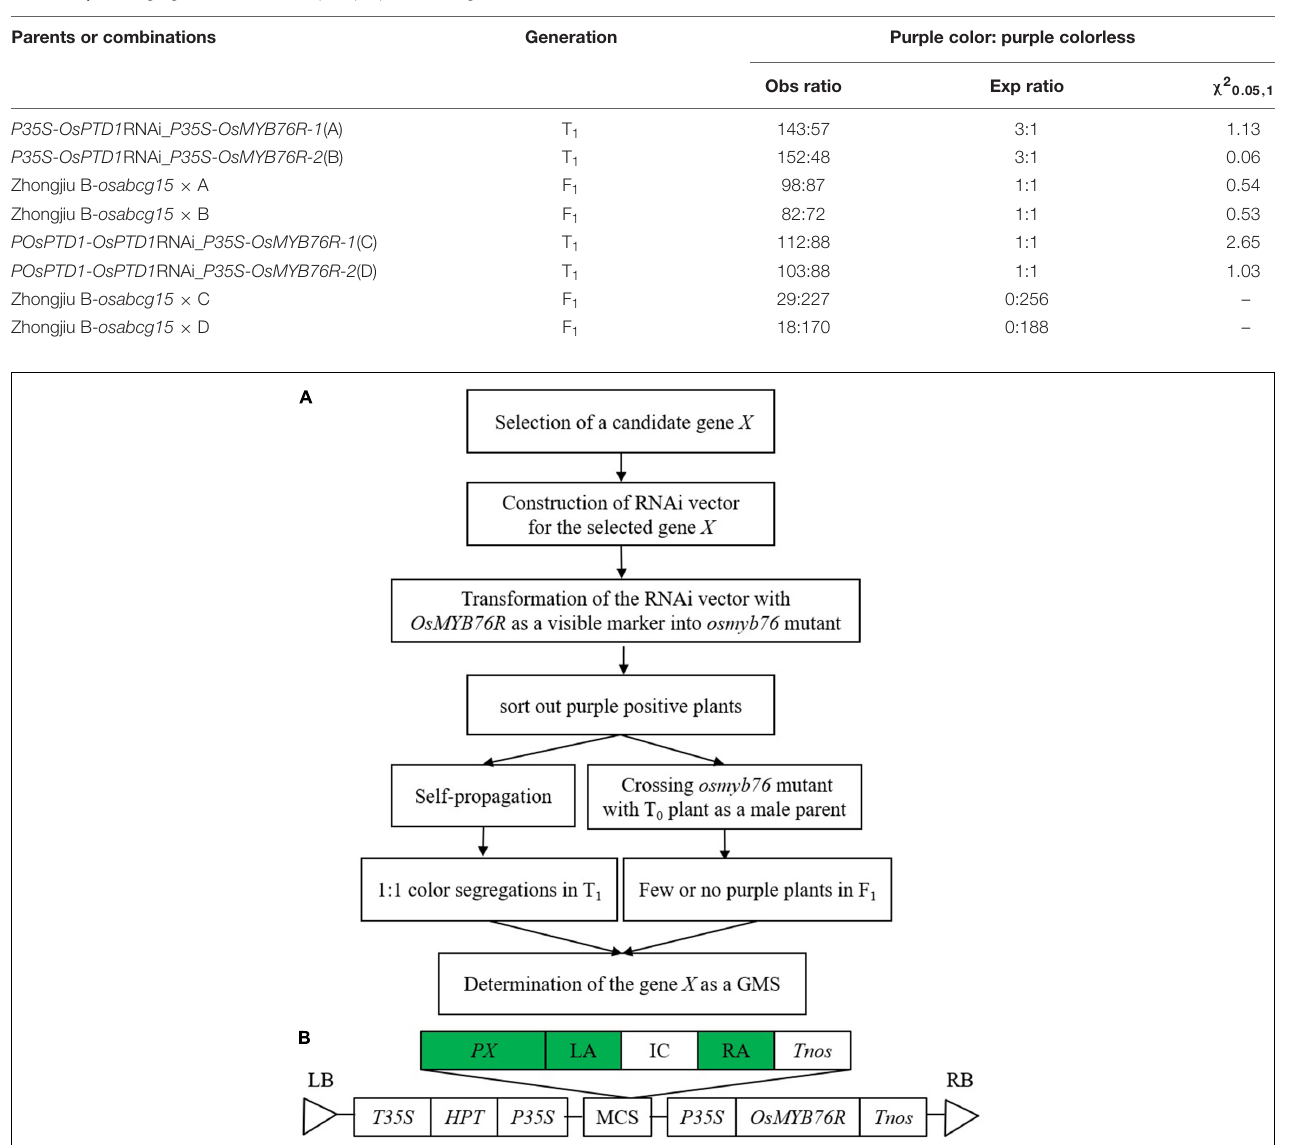
TABLE 1 | The segregation ratio of coleoptile purple color in generations of OsPTD1 RNAi. Parents or combinations Generation Purple color: purple colorless